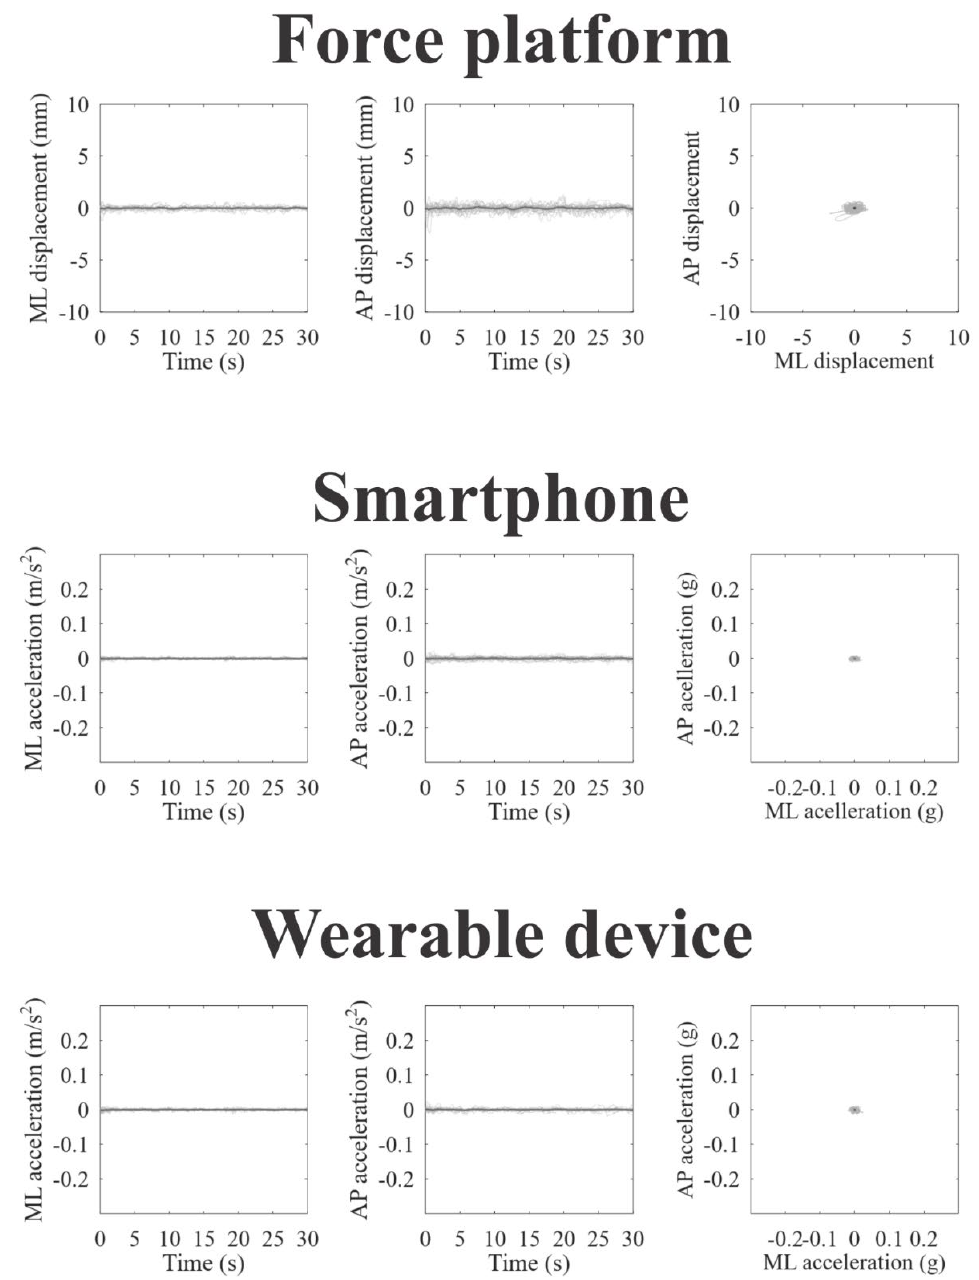
Figure 3. Static balance assessment in closed eyes condition obtained from the force platform (upper line plots), smartphone (intermediate line plots), and wearable device (lower line plots). For all instruments is shown stabilogram on the mediolateral axes (in the left); stabilogram on the anteroposterior axes; (in the center), and statokinesiogram (in the right) The black lines represent the grand mean recording, while the gray lines represent the individual recordings.